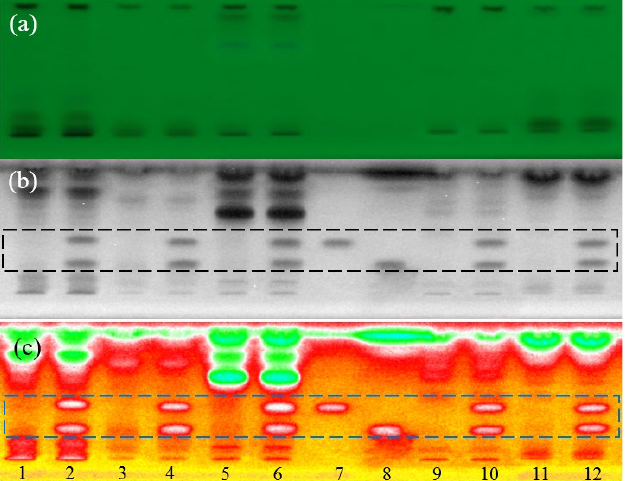
Figure 3. Images of a developed plate under different conditions: ( a ) underivatized-254 nm light, ( b ) dipped into bacterial suspension-bioluminescence inhibition (black/white mode) and ( c ) dipped into bacterial suspension-bioluminescence inhibition (color mode). Track assignment: 1 LL, 2 spiked LL, 3 AC, 4 spiked AC, 5 GB, 6 spiked GB, 7 CPF standard, 8 BZF standard, 9 GS, 10 spiked GS, 11 CT and 12 spiked CT; mobile phase ethyl acetate+methanol (9/1, v / v ), standards concentration 150 ng/zone.